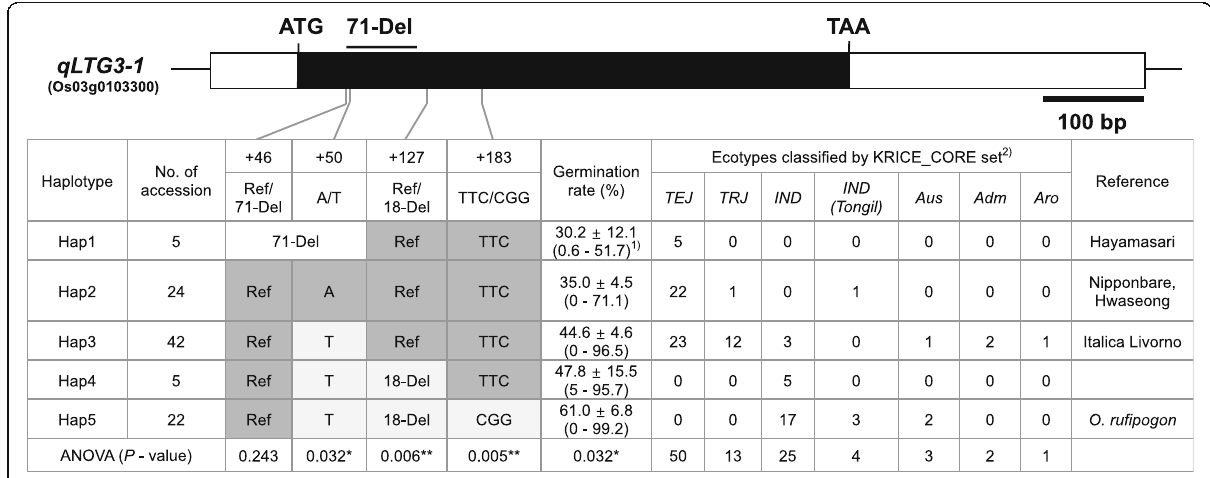
Fig. 4 Haplotype analysis of the qLTG3 – 1 using the 98 rice accessions from the KRICE_CORE set. The germination rate was represented as mean ± standard error and measured 6 days after incubation at 13 °C. 1) Values in parenthesis are minimum and maximum germination rates of each haplotype. 2) TEJ = temperate japonica ; TRJ = tropical japonica ; IND = indica ; IND (Tongil) = indica Tongil ; Aus = aus ; Adm = admixture ; Aro =